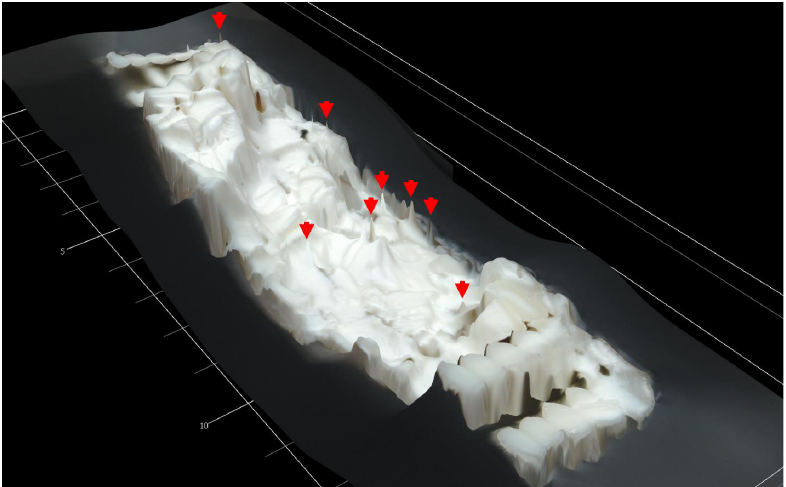
Figure 9. 3-D scan of fracture surface of single-material ULTEM 9085 part. Conical shapes formed by necking during plastic strain shown by red